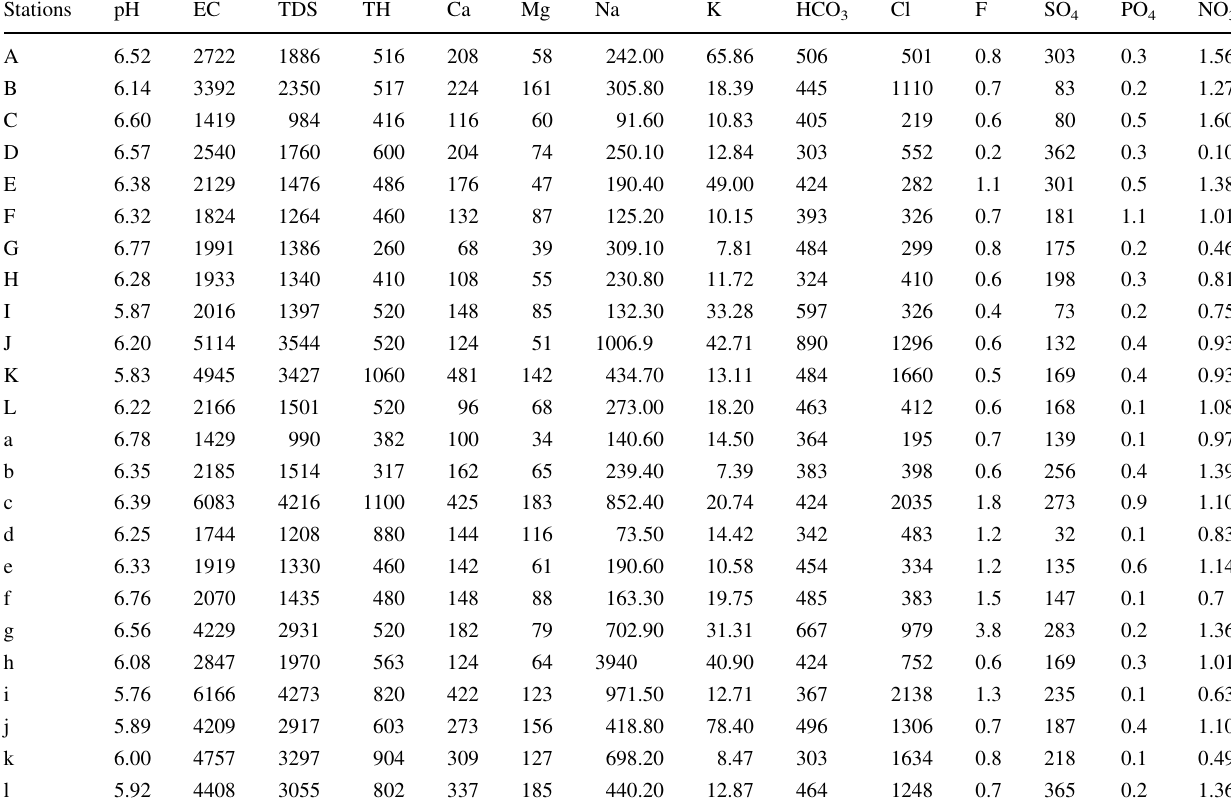
Table 2 Physico-chemical characteristics of the groundwater samples (May 2013)